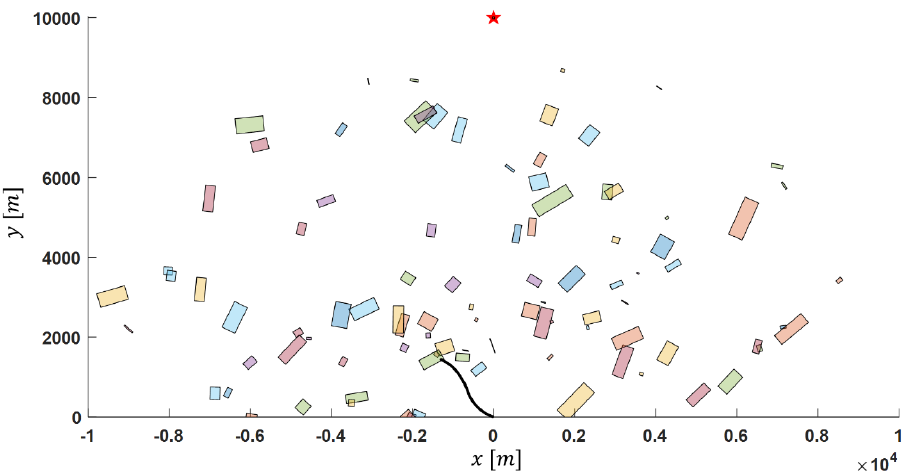
Figure 17. Failed trajectory for scenario A.